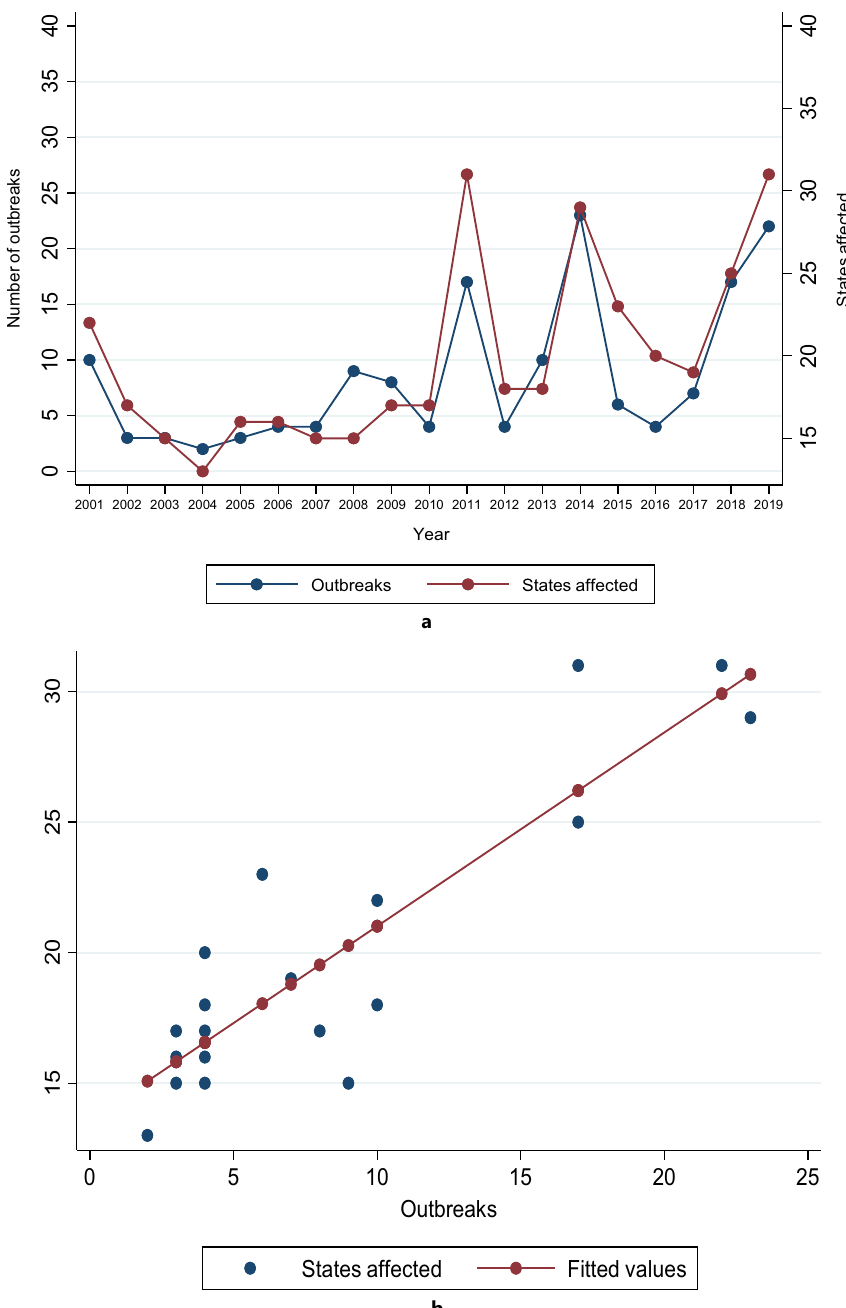
Figure 4. ( a ) Number of measles outbreaks and number of states affected by measles between 2001 and 2019. The red connected line represents the number of states affected and the blue connected line represents the number of outbreaks. There was a significant increase in the number of outbreaks from 10 in 2001 to 22 in 2019. There was a significant increase in the number of states affected from 16 in 22 in 2001 to 31 in 2019. ( b ) Linear regression model of the association between the number of outbreaks and the number of states